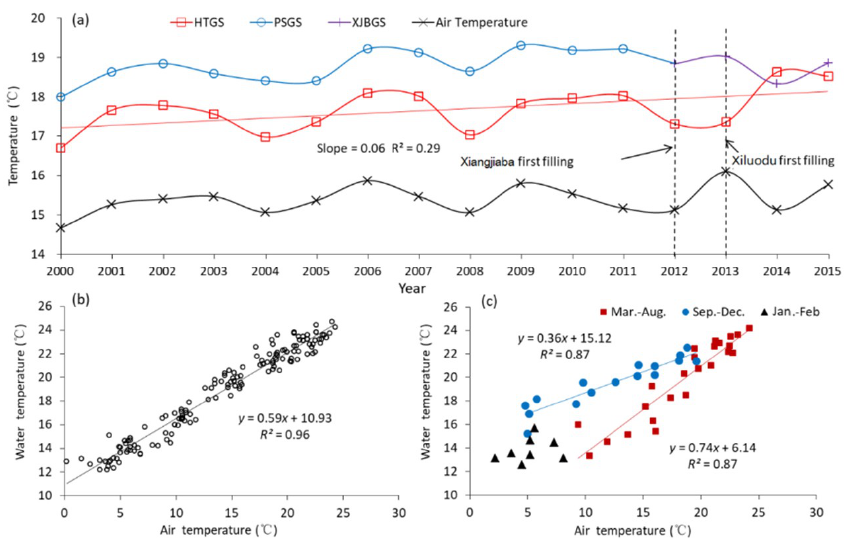
Figure 4. ( a ) Annual mean water temperature at HTGS, PSGS, and XJBGS from 2000 to 2015. Black symbols show the annual mean air temperature in the reservoir basin. Solid lines indicate significant linear trends of mean water temperature at HTGS; ( b ) Correlation between monthly mean air temperature and water temperature during the pre-impoundment period. The solid line shows a linear regression (according to the equation in the legend); ( c ) Correlation between monthly mean air temperature and water temperature during the post-impoundment period, with different colors denoting different seasons (see legend). Solid lines show linear regressions (equations provided in legend).